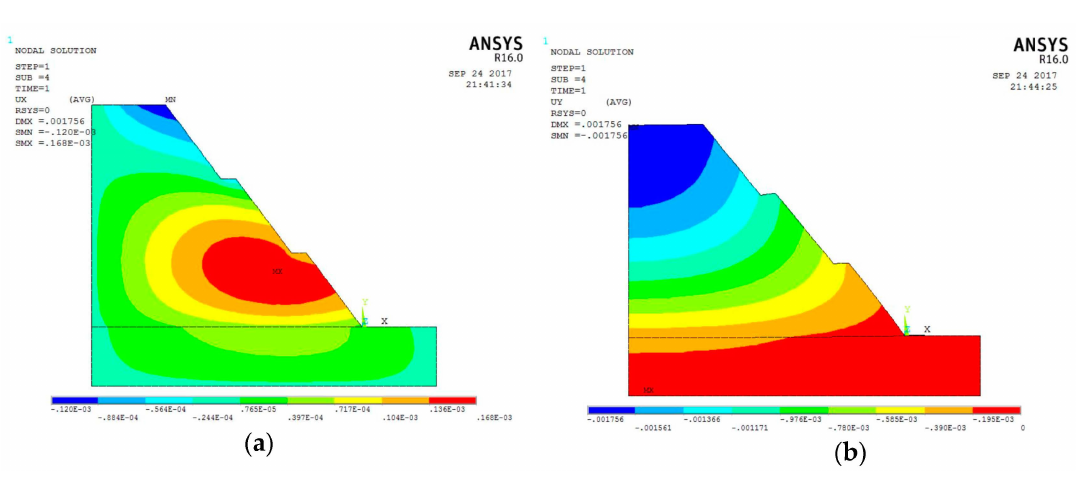
Figure 3. Displacement nephograms: ( a ) X direction; ( b ) Y